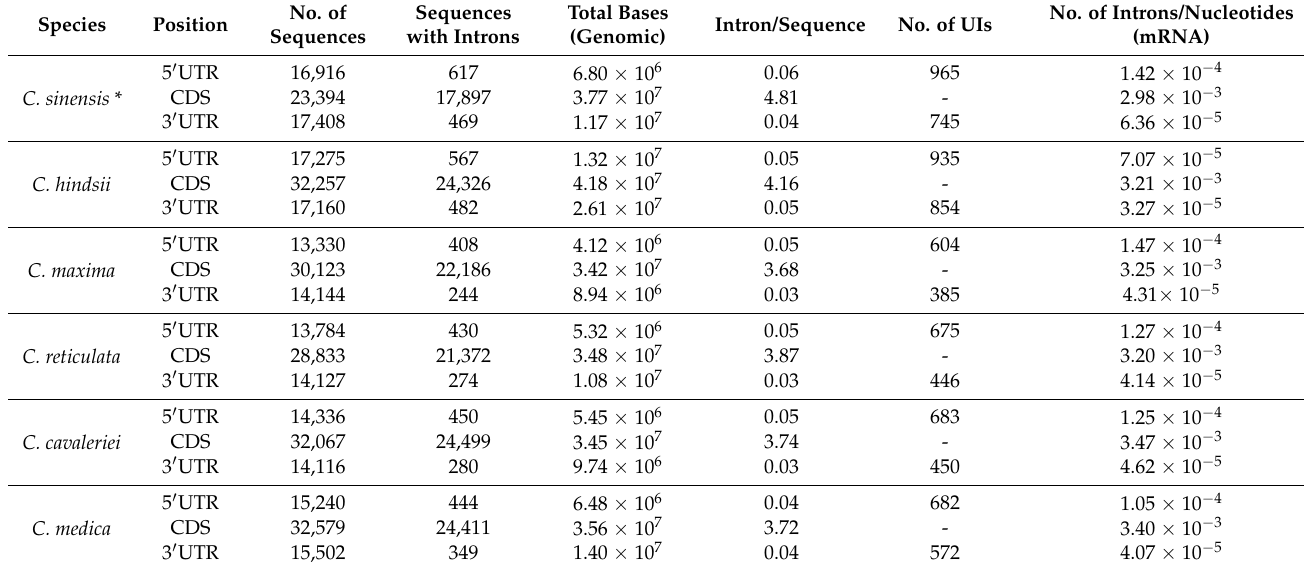
Table 1. Statistics information of 5 (cid:48) UTR, CDS and 3 (cid:48) UTR in six citrus species. CDS: coding sequence; UI: UTR intron; *: cited from reference